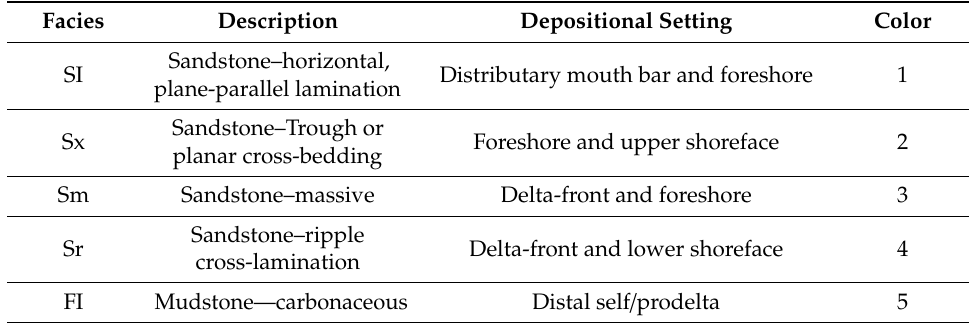
Table 1. The five lithofacies identified from cores of the Lower Grandstand Member in Umiat 18 (Modified from LePain et al., 2018